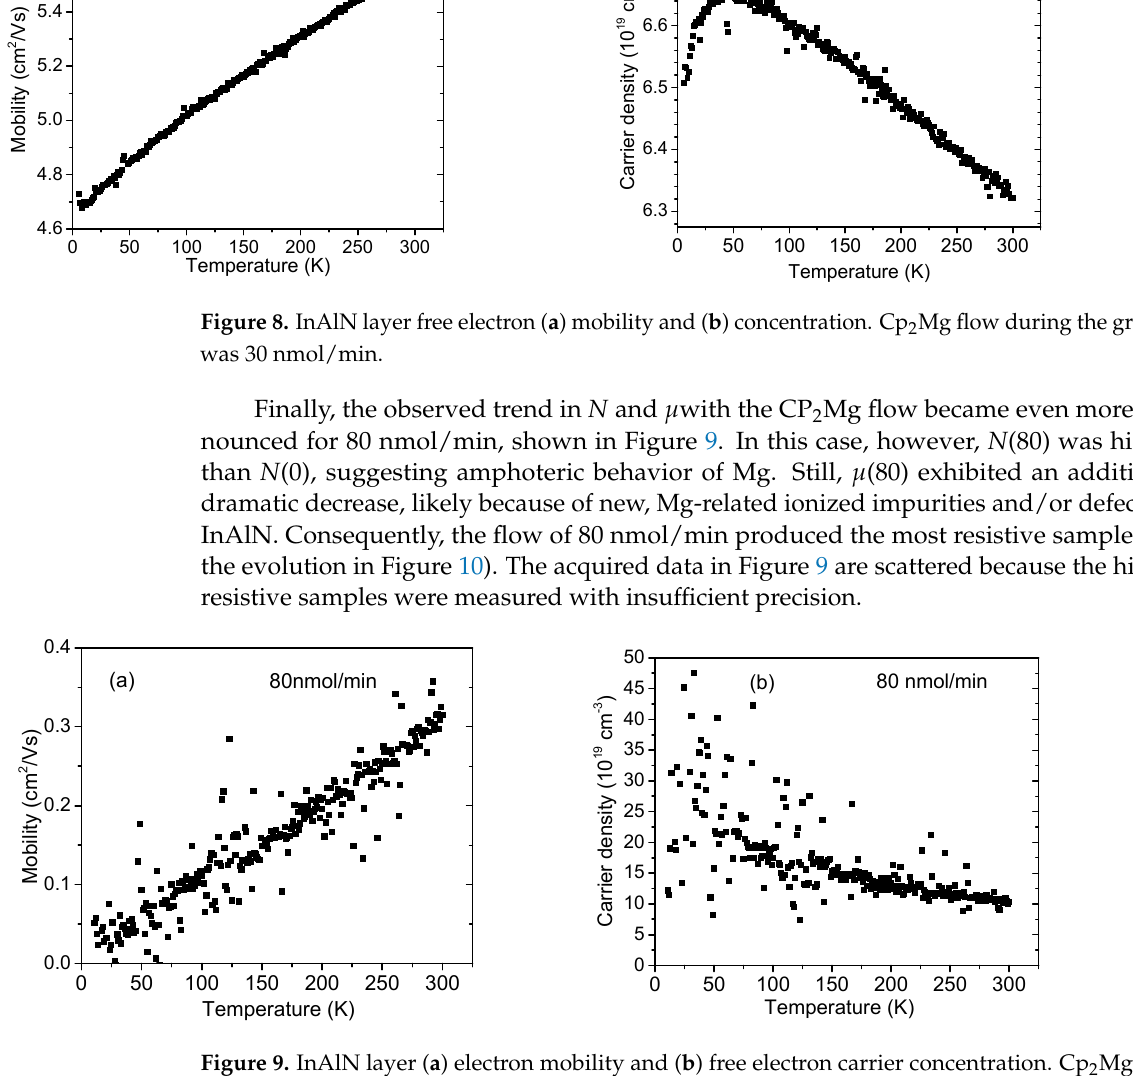
Figure 9. InAlN layer ( a ) electron mobility and ( b ) free electron carrier concentration. Cp 2 Mg flow during the growth was 80 nmol/min.